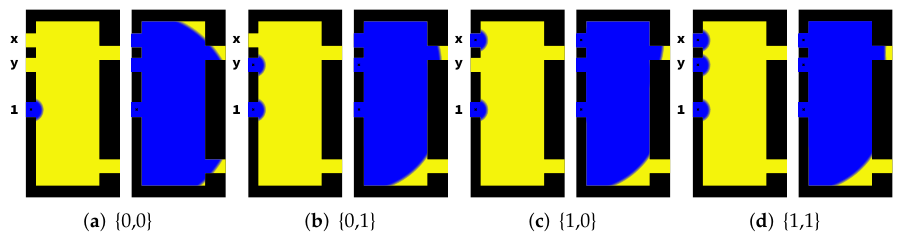
Figure 15. Example of a 2-input NOR gate chemical topology. Input ( left ) and result ( right ) time frames for each possible input { x , y } .